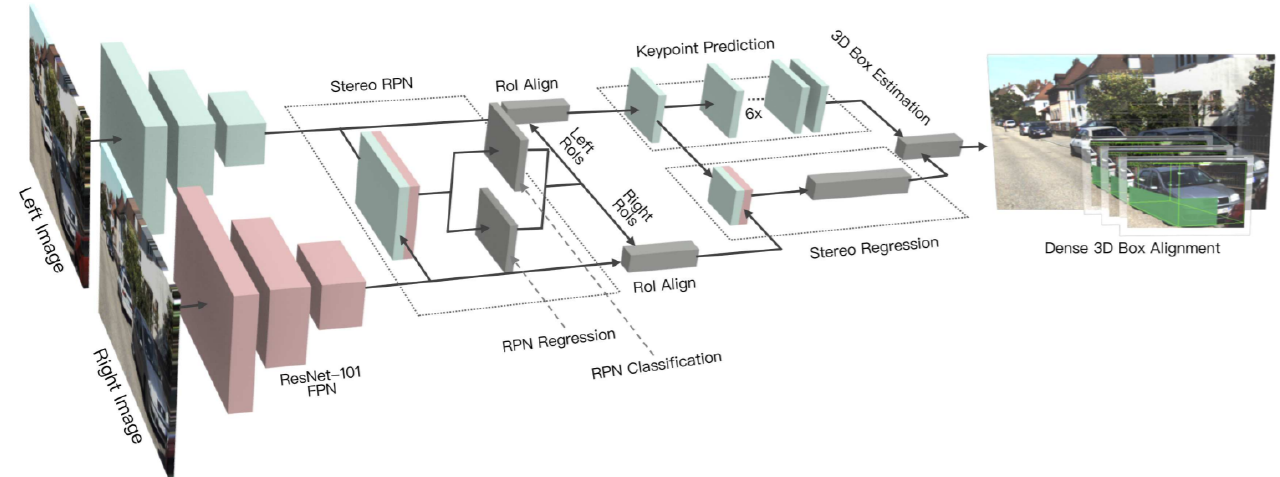
Figure 9. The architecture of Stereo R-CNN [59], which outputs key points, stereo boxes, along with the viewpoint angle and dimensions, followed by 3D BBox